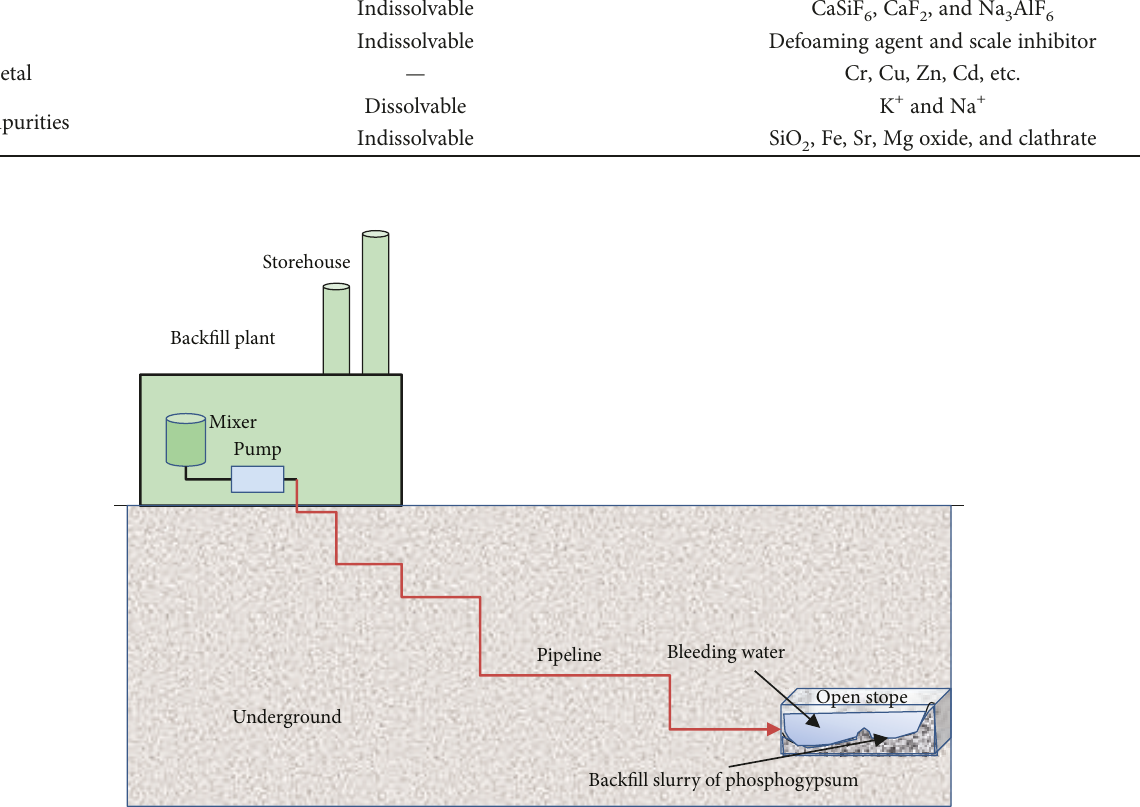
Figure 1: Sketch map of the PG underground mine back fi ll.